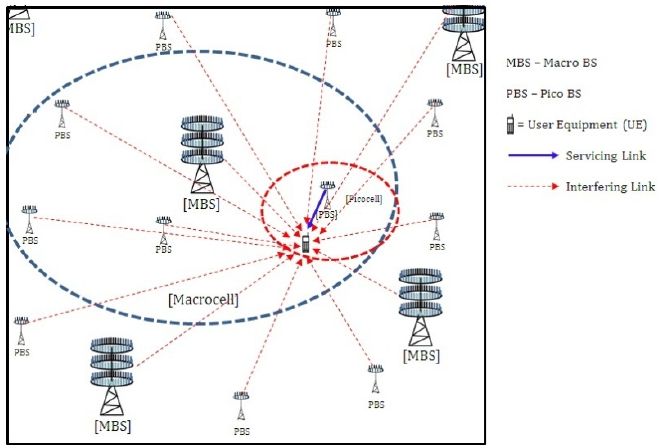
Figure 1. Schematic representation of a typical massive MIMO-enabled two-tier heterogeneous network (HetNet).